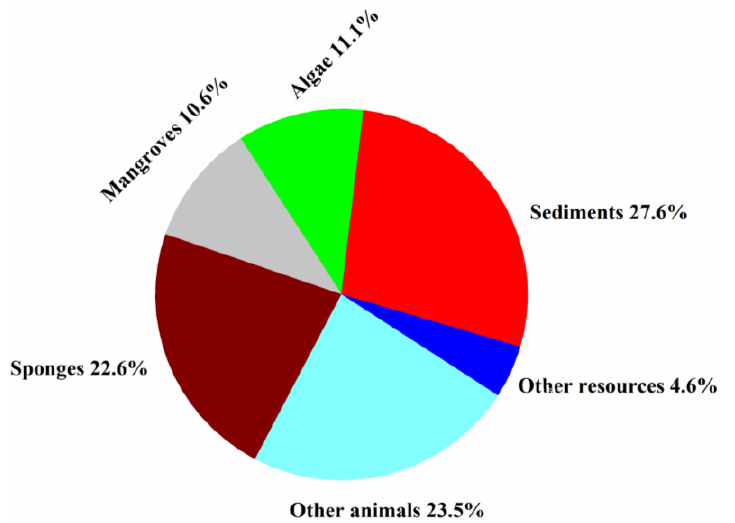
Figure 9. Percentages of new halogenated compounds from different sources of marine origins (1994–2019).